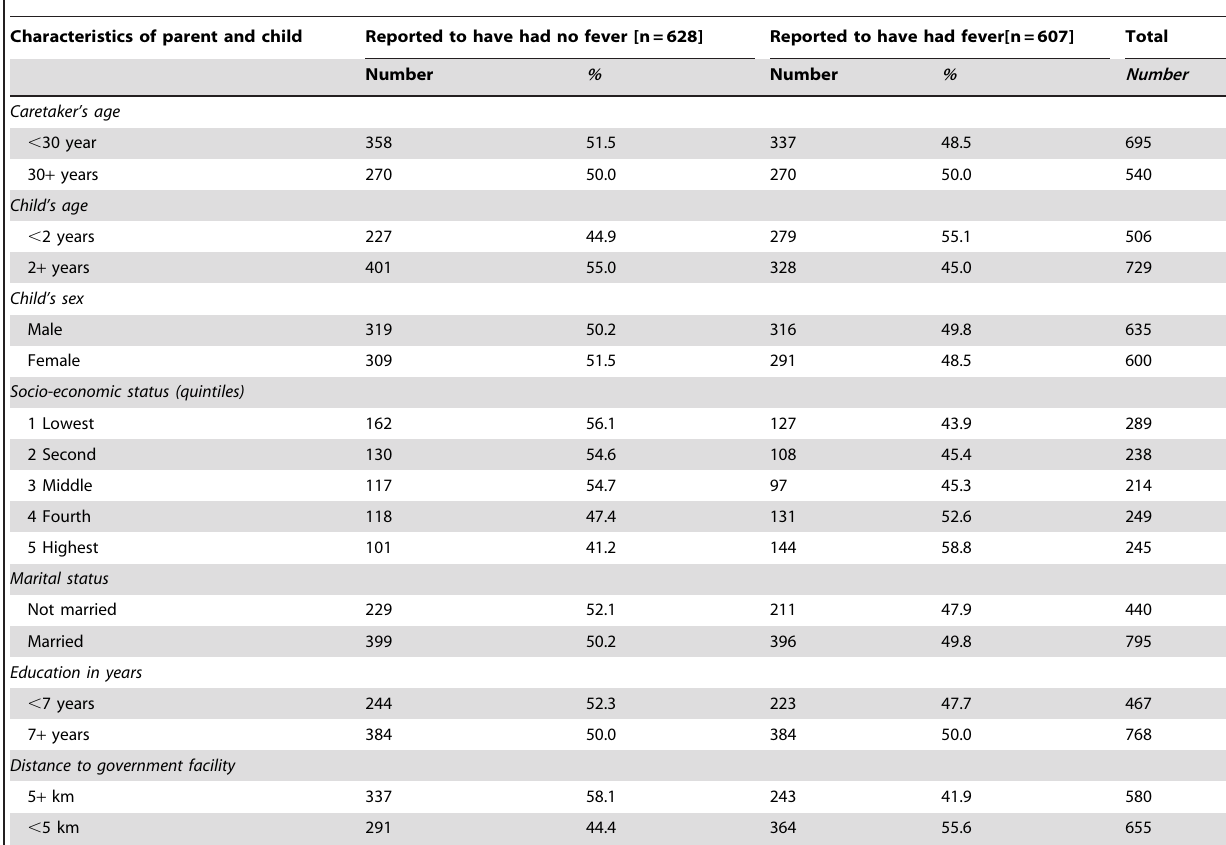
Table 1. Background characteristics of study population by reported fever status and their caretakers.